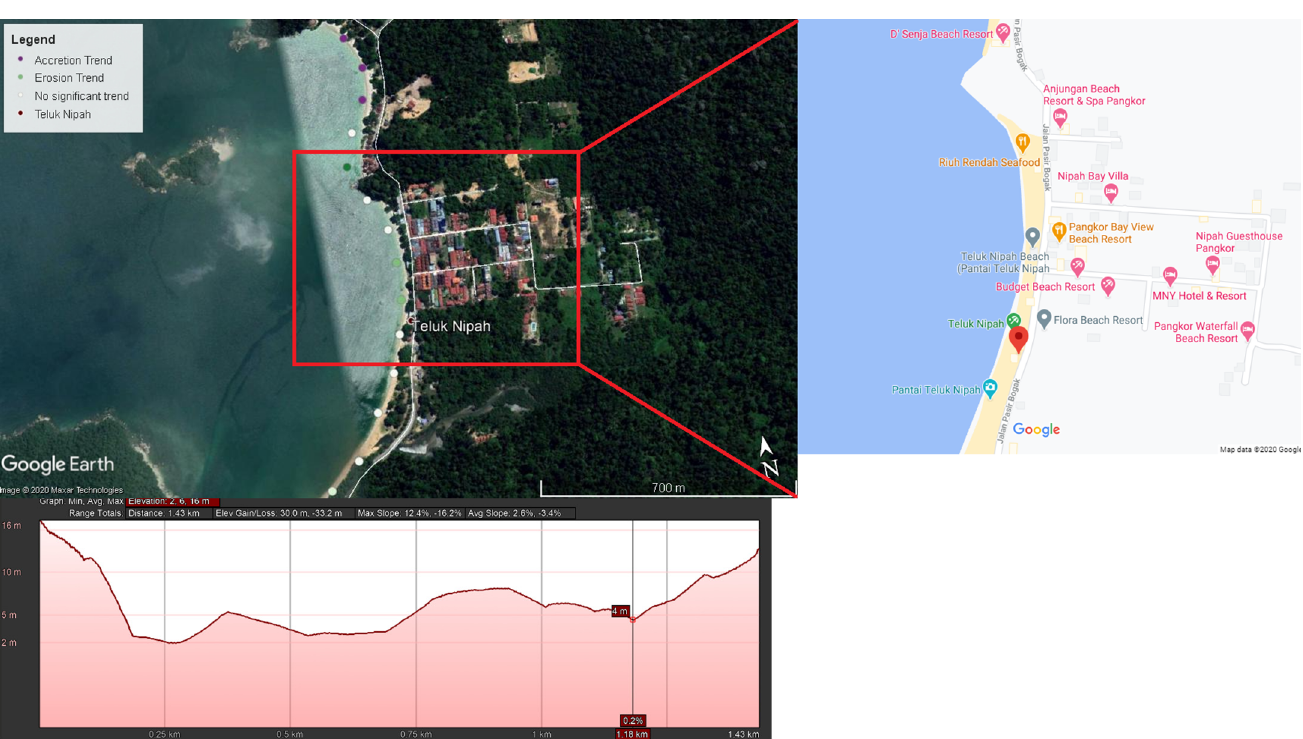
Figure 9. Elevation profile and development along the coast of Teluk Nipah Beach. The profile was drawn over the July 2020 shoreline, along the north direction.